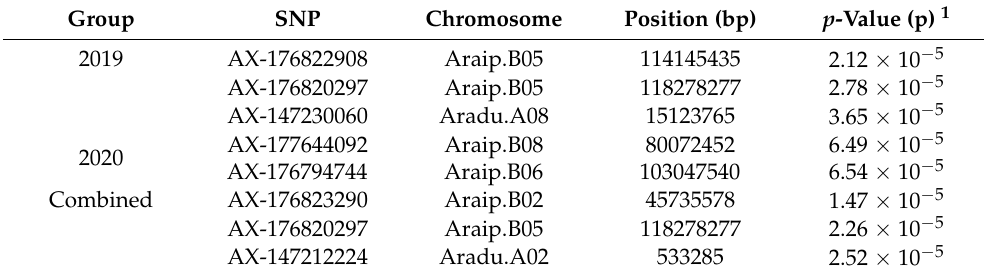
Table 1. Significant markers associated with the leaf chlorophyll content of peanuts identified using GAPIT